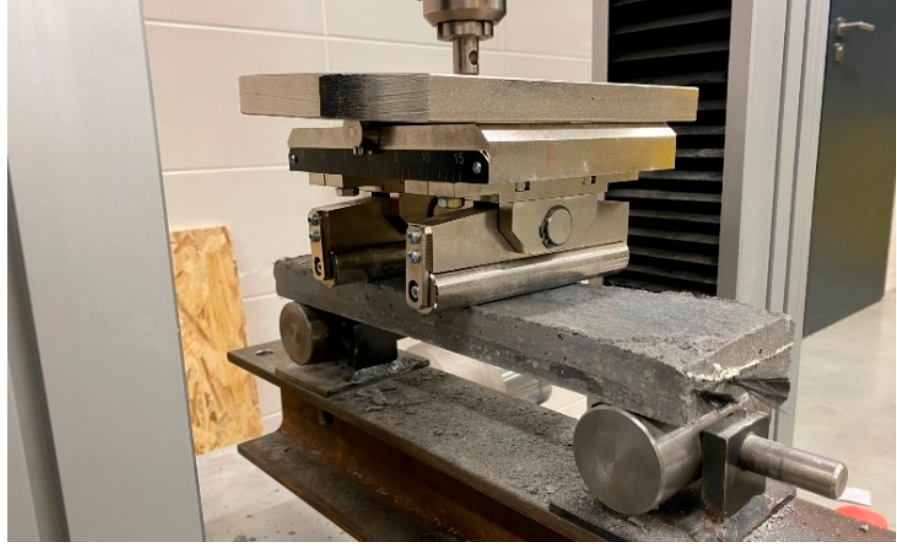
Figure 5. Test specimen place in the mechanical press for four-point bending test.